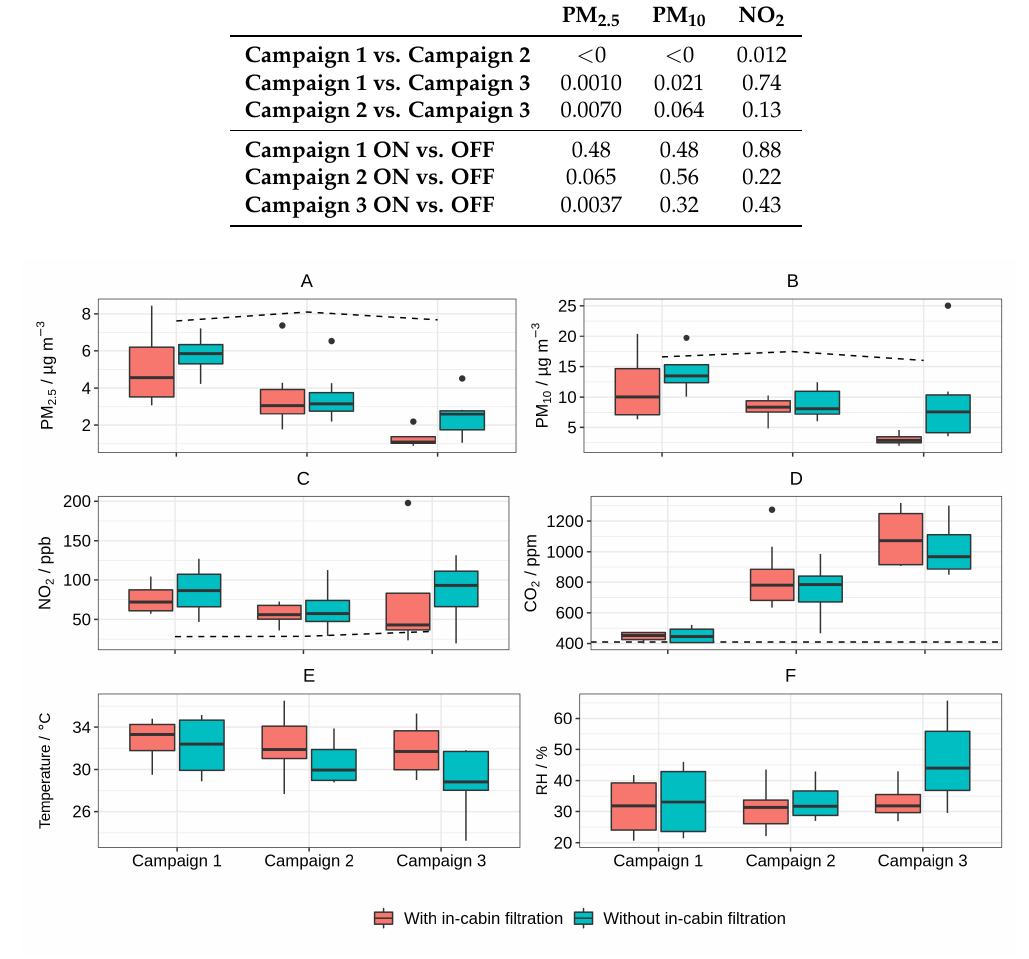
Figure 6. Campaign-averaged in-cabin concentrations of PM 2.5 ( A ), PM 10 ( B ), NO 2 ( C ) and CO 2 ( D ) as well as temperature ( E ) and relative humidity (RH, F ) for the three different campaigns with standard deviations. All averages are based on 1 min time averages. The black, dashed line represents the background concentration measured at the fixed road reference monitor at Marylebone Road in the same period as the